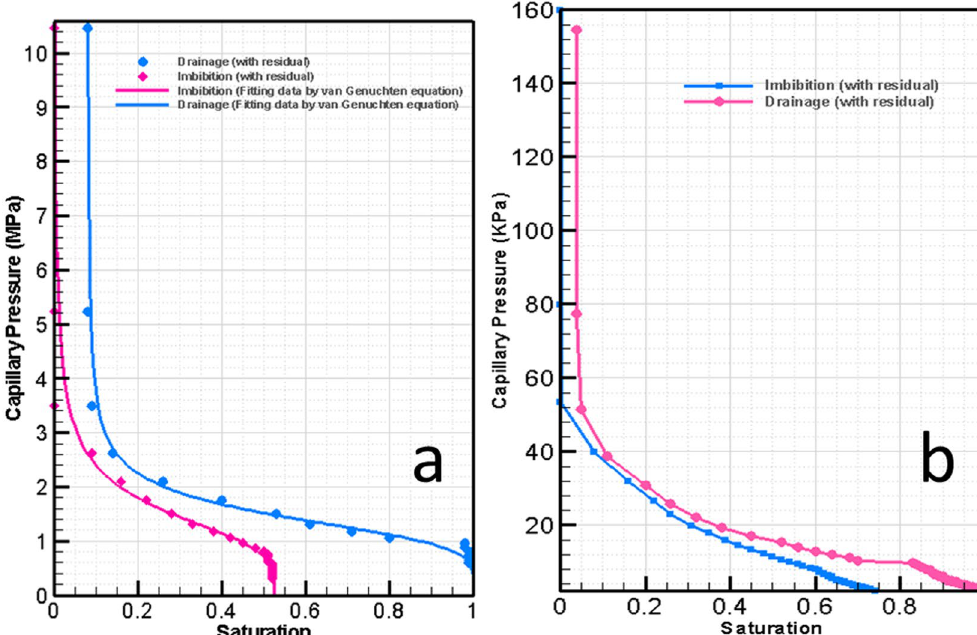
Figure 13. Capillary pressure curves for; ( a ) coating layer and ( b ) fibrous layer 16 .